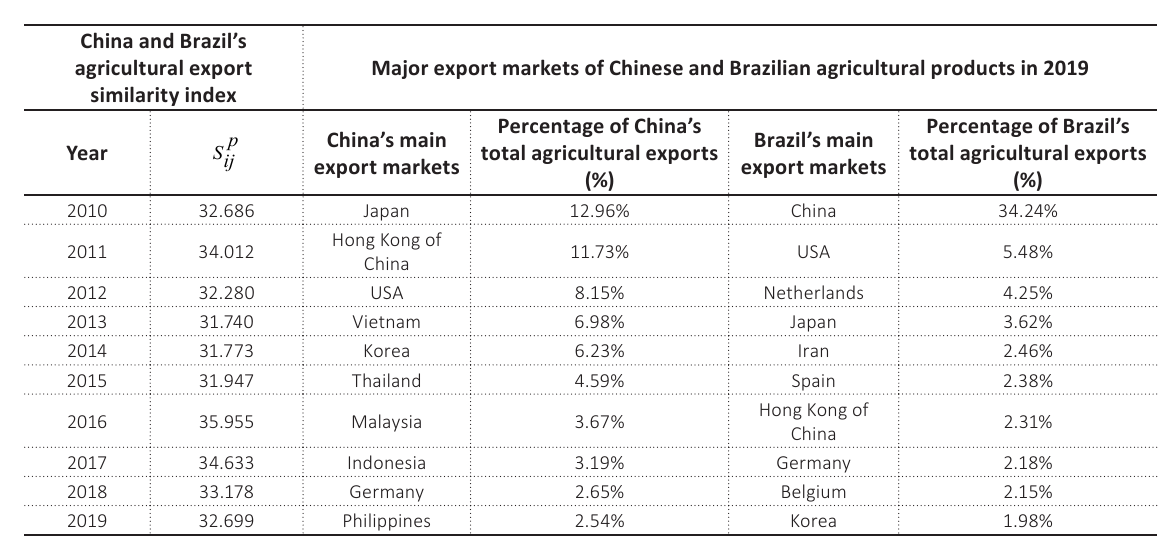
Table 5. Similarity index of agricultural export between China and Brazil and their main export